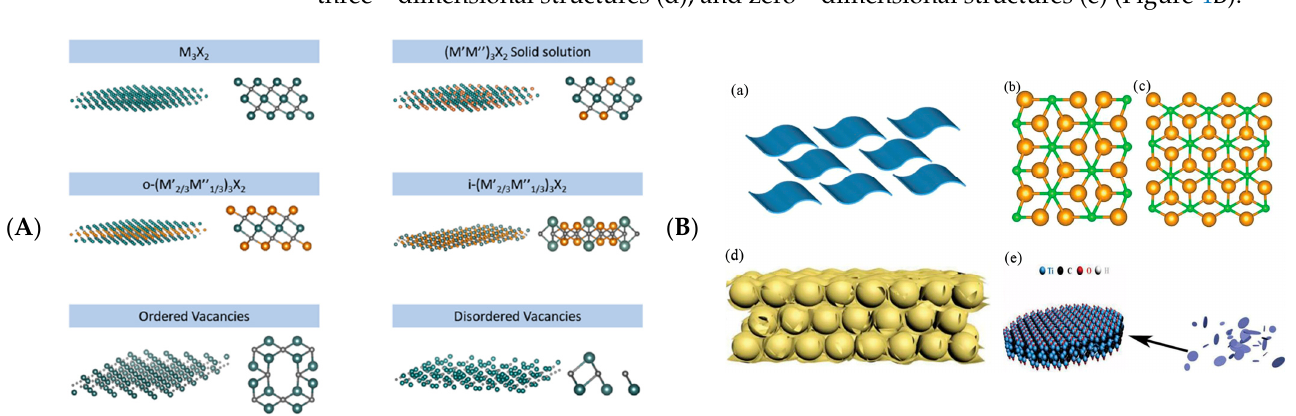
Figure 4. ( A ) Different types of MXenes structures. Reprinted with permission from Ref. [42]. Copyright 2019, Elsevier. ( B ) 2D, 1D, 3D, and 0D structures of MXenes. Adapted with permission from Ref. [18] .Copyright 2021, Wiley-VCH.